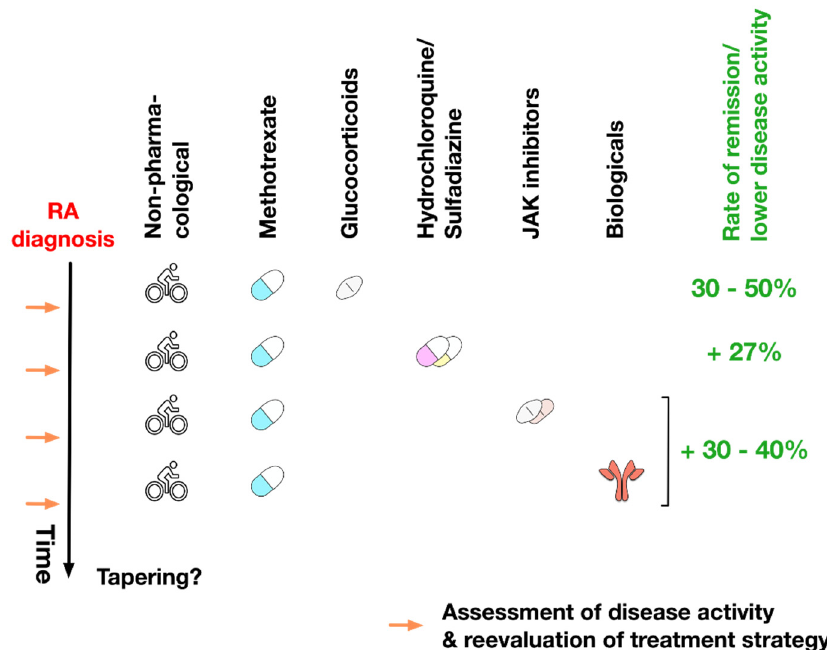
Figure 8. Common treatment plan for the management of RA. Upon initial RA diagnosis (see above) non-pharmacological treatment is provided alongside the application of methotrexate and short-term application of glucocorticoids to reduce joint inflammation, resulting in remission/significantly lower disease activity rates in 30–50% of patients. In non-responsive patients triple therapy consisting of the addition of the conventional synthetic DMARDs hydrochloroquine and sulfadiazine to methotrexate treatment can achieve remission in an additional 10–27% of the patients. Subsequent application of either JAK inhibitors or biological DMARDs can achieve remission/reduced disease activity in an additional 30–40% of RA patients. For optimal treatment it is necessary to constantly reassess both the individual patient’s disease state and efficacy of treatment to make timely adjustments. Once the patient has reached stable remission over at least 6 months, sequential tapering or dose reduction of the administered drugs can be considered in order to reduce treatment-associated side-effects and costs.